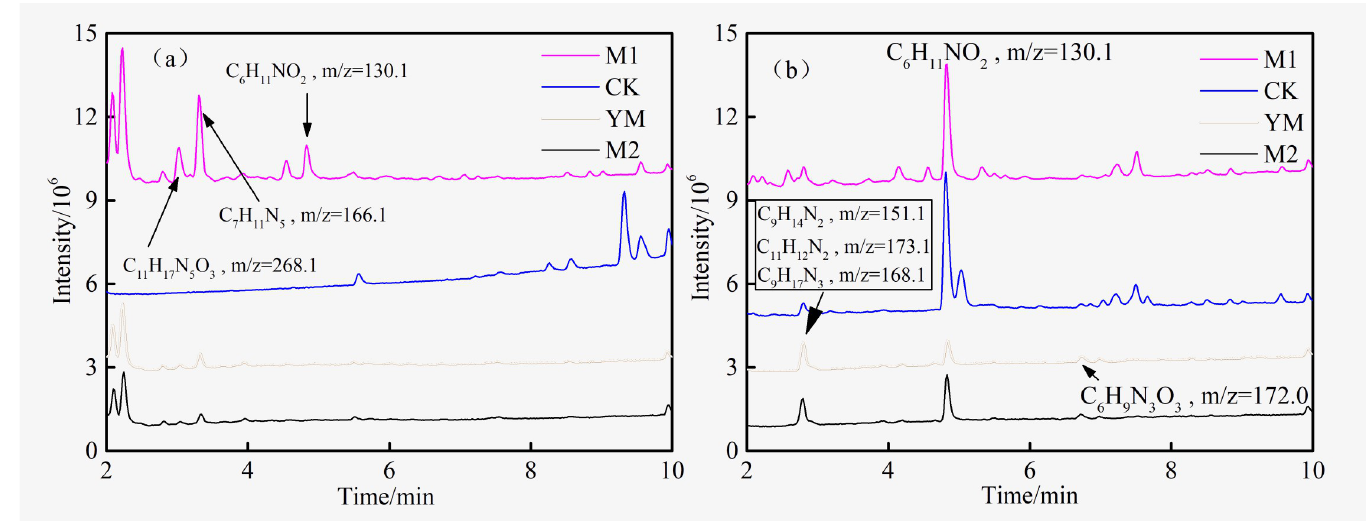
Fig 6. TIC of HPLC-MS of experimental groups before (a) and after (b) biogenic methane production.